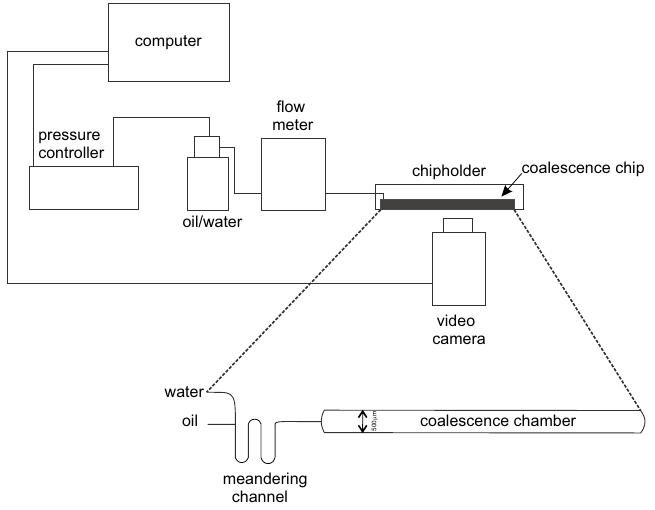
Figure 1. Experimental set-up with the microfluidic coalescence chip shown in inset. The coalescence chip comprises of three parts: the T-junction for formation of droplet and emulsion, the adsorption channel (U-shaped) for surfactant adsorption and finally, the wider coalescence chamber for allowing droplet collision and